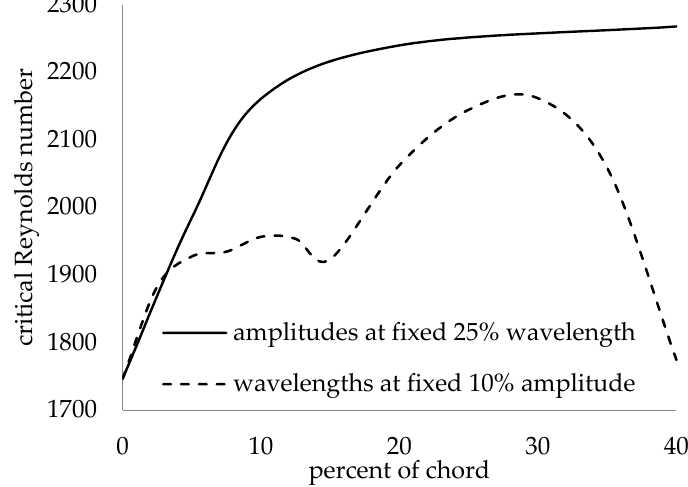
Figure 18. Critical Reynolds numbers for different LE geometries.